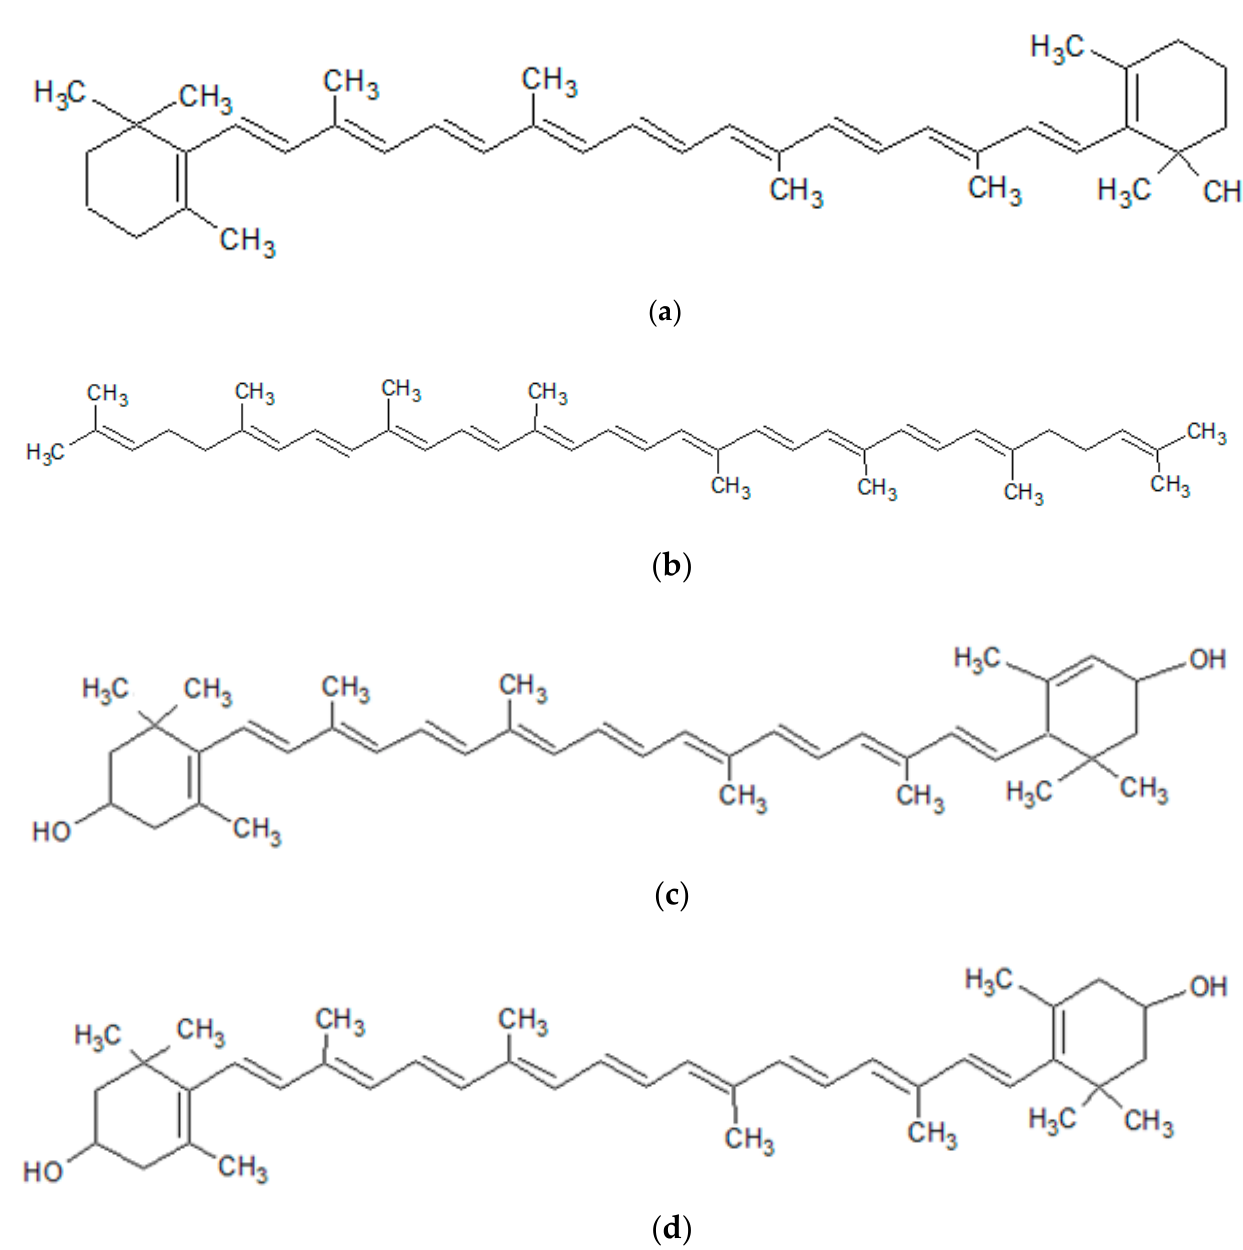
Figure 8. Structures of the major carotenoids: ( a ) β -carotene; ( b ) lycopene; ( c ) lutein; ( d ) zeaxanthin (own work). Carotenoids are present in plants—imparting a yellow-to-red color to the flowers, fruits or leaves—and in the marine environment, as a red–orange pigment common in many aquatic animals [220–222] (Table